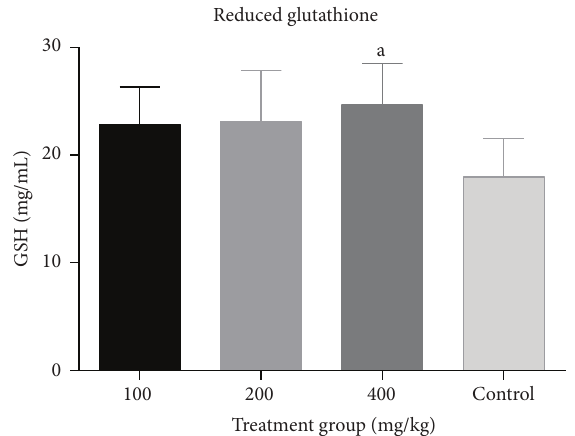
Figure 10: Effect of combined aqueous extracts of Azadirachta indica and Khaya senegalensis on catalase activity of the liver of healthy chickens. Values are expressed as mean ± SEM where 𝑛 = 5 . a Significant as compared with control ( 𝑝 < 0.05